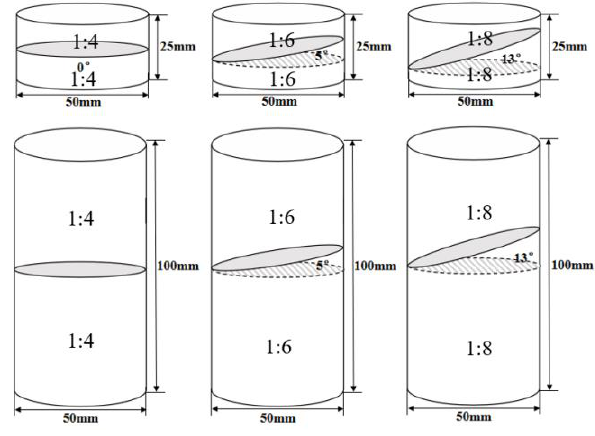
Figure 2. Schematic diagram of layered backfill specimens.